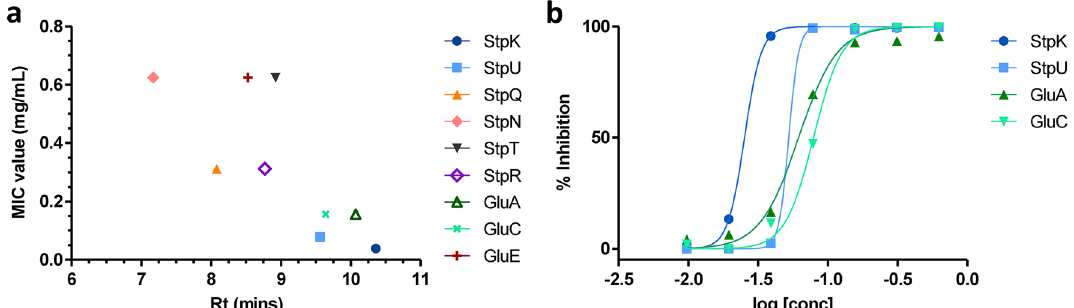
StpK [ m/z 682 ( 12 ) and 684 ( 14 ), respectively] and GluC and GluA [ m/z 559 ( 22 ) and 585 ( 26 ), respectively].